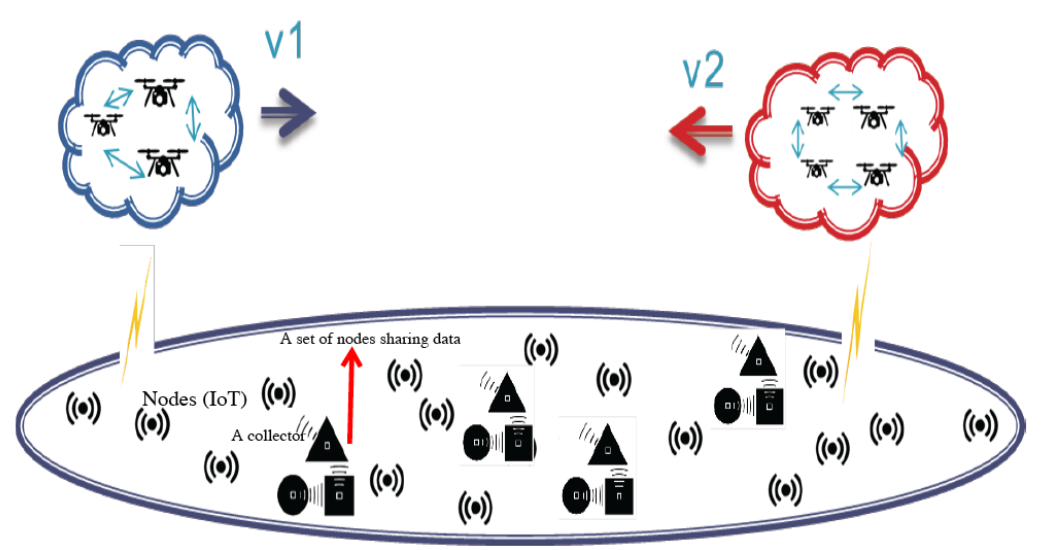
Figure 3. UAV-based cloud computing for IoT applications utilizing services provided by different collectors and